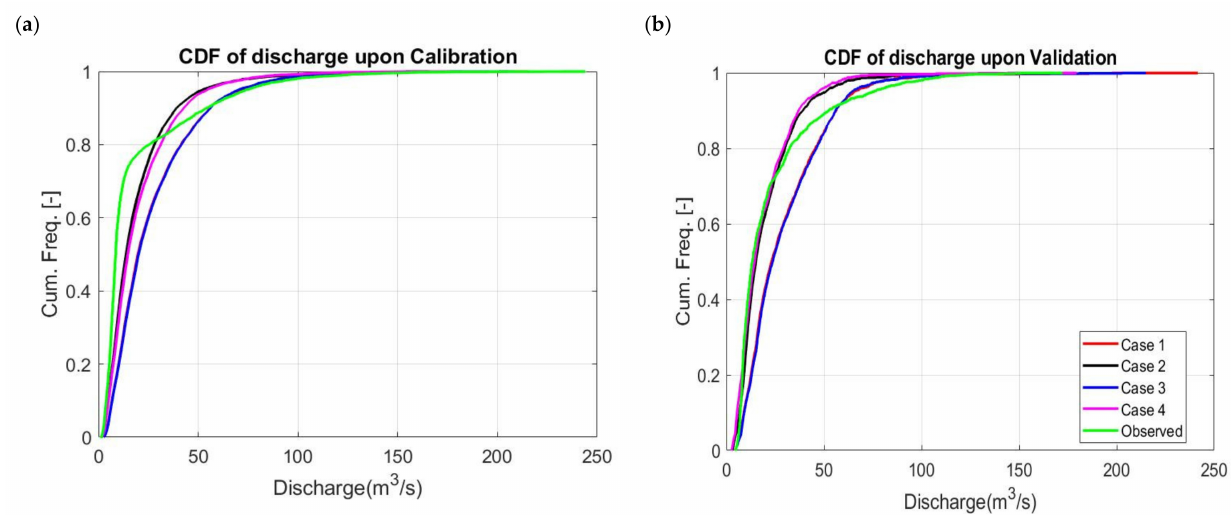
Figure A1. Selected CORINE and MODIS land cover maps of the study area for CORINE 1990, CORINE 2012, MODIS 2001 and MODIS 2008.